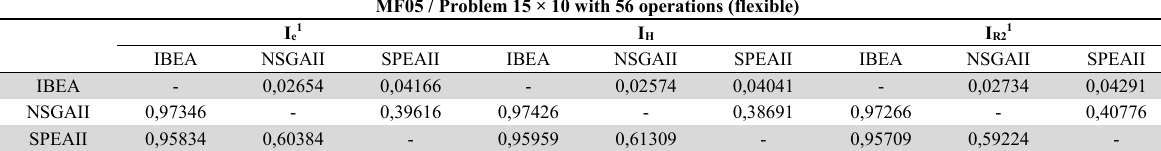
values in the frontier of the actually obtained values f 1 and f 2 :